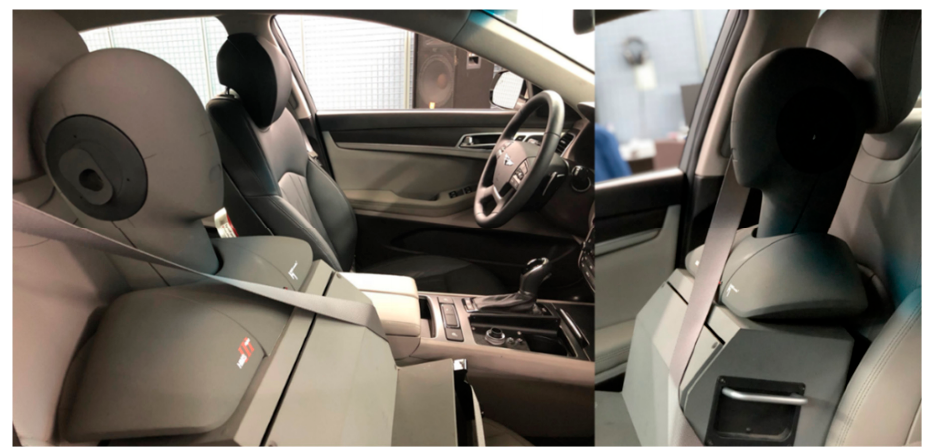
Figure 2. Dummy head used in the study and an example of the installation.